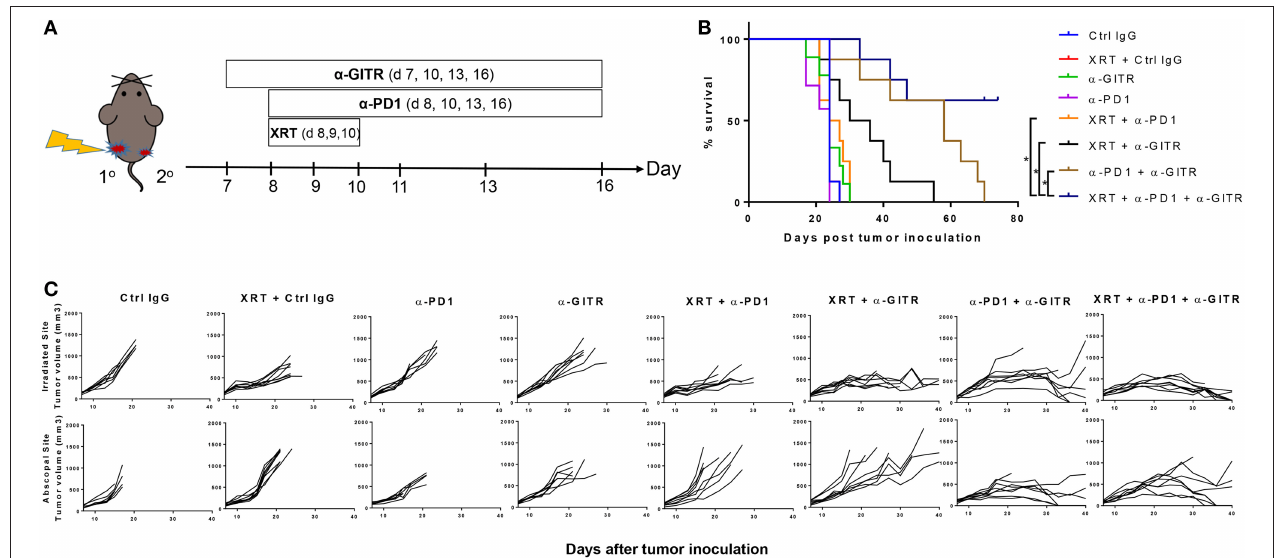
FIGURE 1 | Anti-GITR combination therapy with anti-PD1 and XRT in 344SQ resistant tumors increases overall survival and promotes abscopal effects. Mice were inoculated on both right (primary) and left (secondary) legs with the second inoculation occurring 4 days after the first. (A) Anti-GITR therapy began on day 7 post inoculation and XRT began on day 8 post primary tumor inoculation with anti-PD1. (B) Plots of individual tumor growth values for primary tumors of various treatment arms ( n = 8 per group), and (C) plots of survival by treatment group. * P ≤ 0.05 in Log-rank